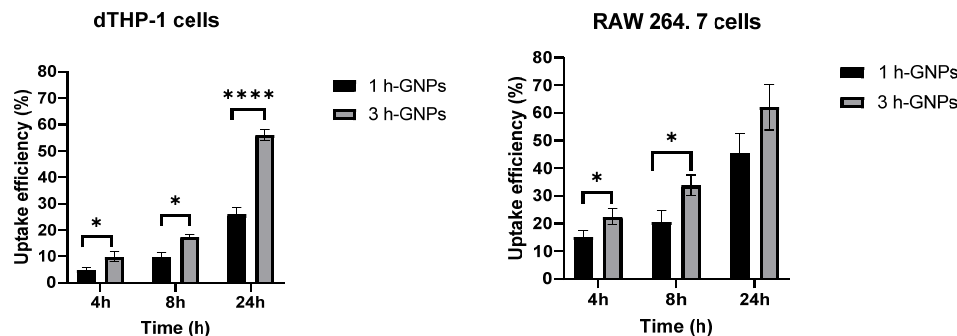
Figure 6. Cell uptake efficiency of GNP (1 h, soft and 3 h crosslinked, stiff) by RAW 264.7 and dTHP-1 cells for 4, 8 and 24 h. Data is presented as mean ± SD as percentage of the applied particle dose, * Different from 1 h crosslinked GNP ( p < 0.05), **** Different from 1 h crosslinked GNP ( p < 0.001).